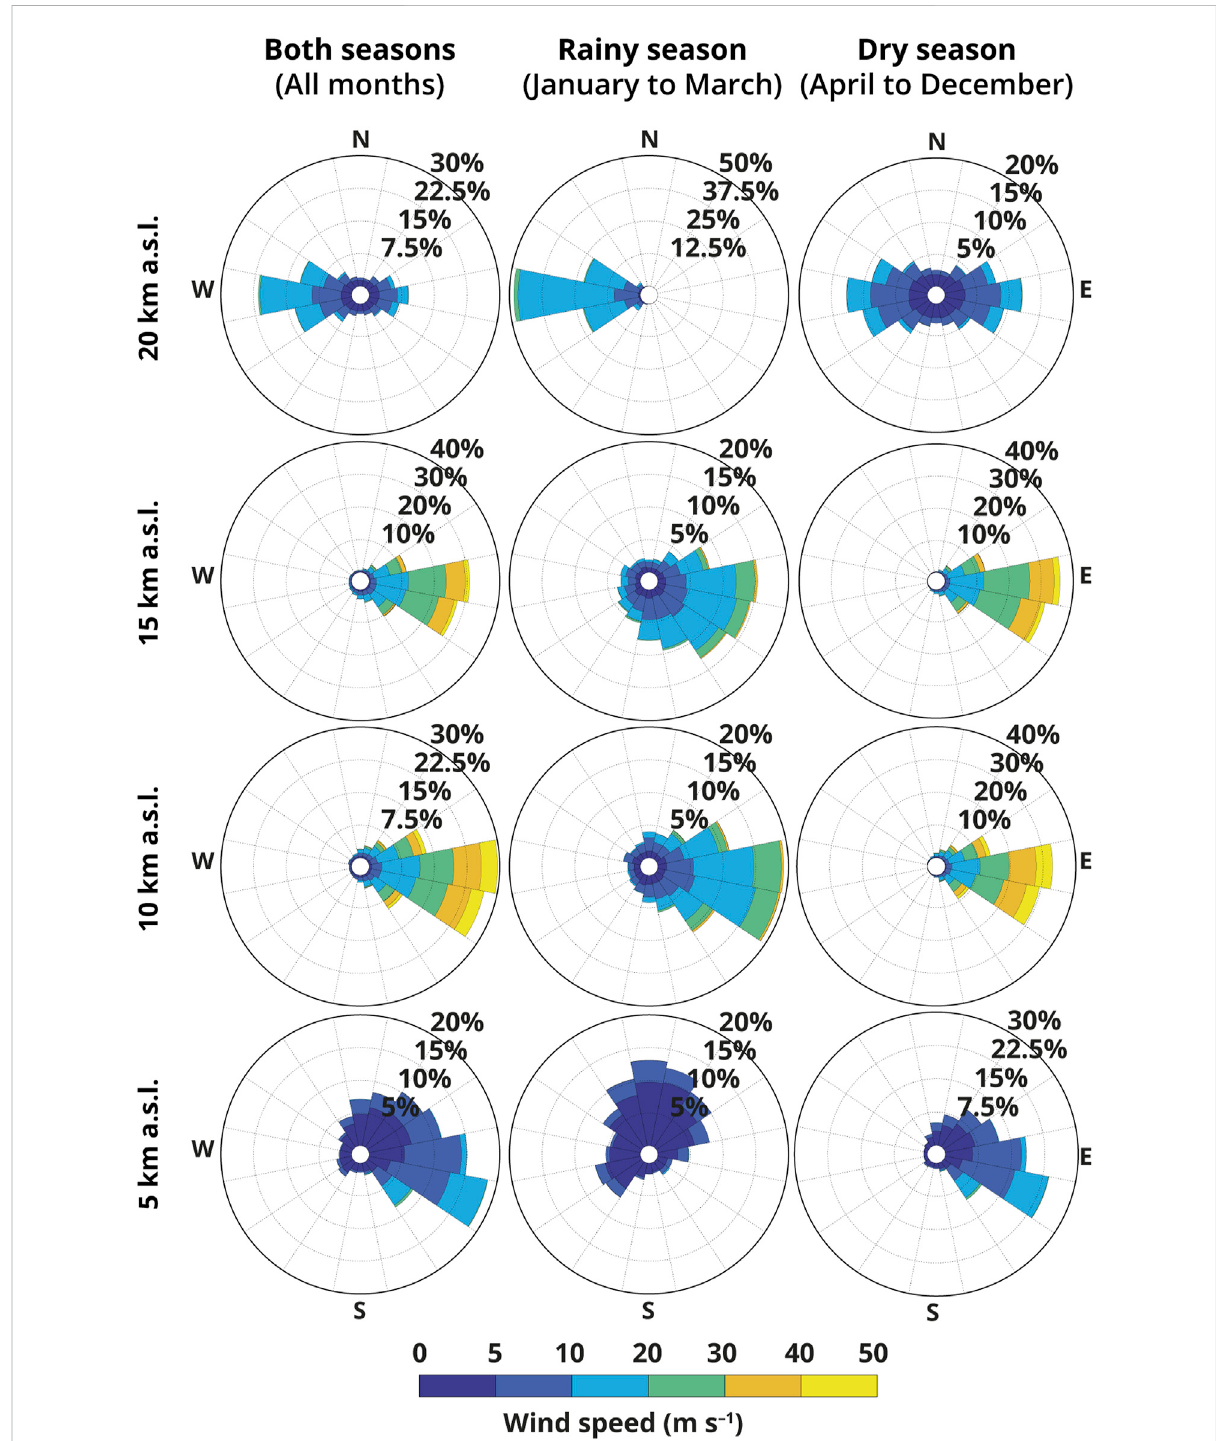
FIGURE 3 San Pedro ERA5 wind data set. The fi gure shows wind fi eld data obtained from the ERA5 dataset and plotted with the TephraProb toolbox.